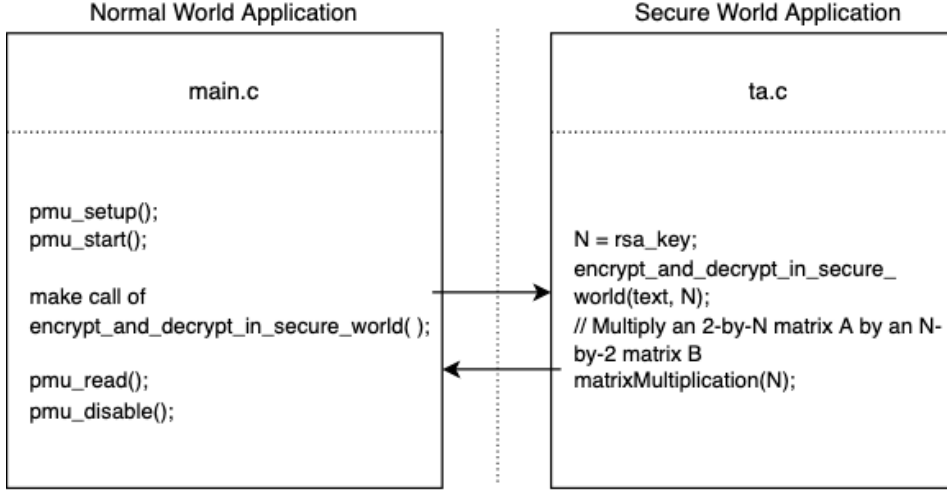
Figure 2. The code used in the synchronous attack model.